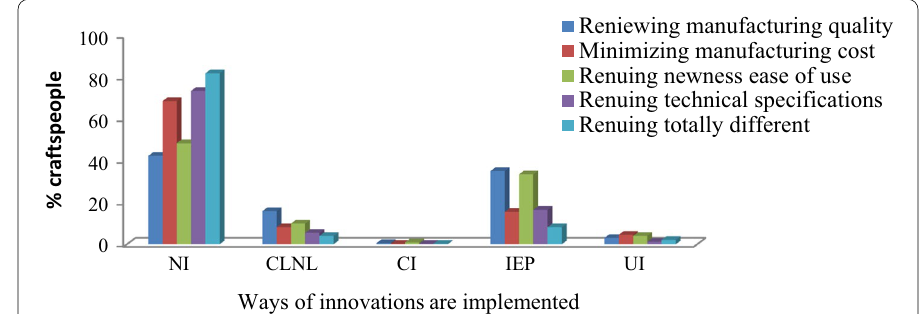
Fig. 4 Craftspeople product innovation implemented. NI Not implemented, CLNL copied from local and national level, CI copied from international level, IEP improved from own experience and product, UI unique breakthrough